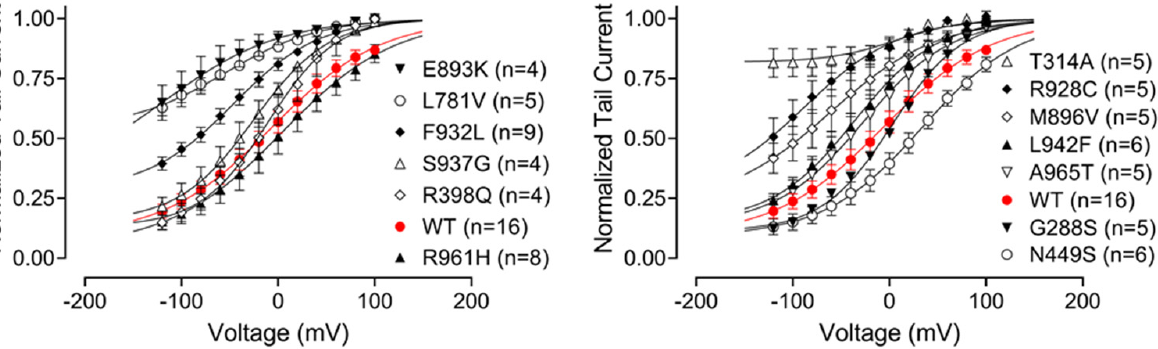
Figure 3. The effect of GoF mutations of the kinetics of KCNT1 currents. WT and Mutant KCNT1 currents were recorded in response to the voltage protocol shown in the lower right-hand corner.